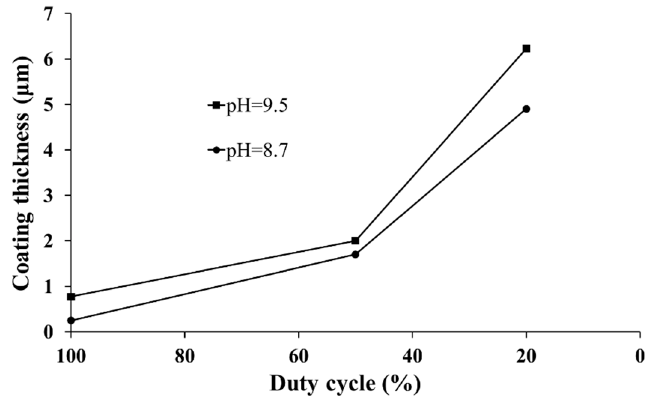
Figure 7. The maximum thickness of crack-free coatings versus the duty cycle (the duty cycle of 100% corresponds to the DC mode). The current density was 0.05 A·cm − 2 .